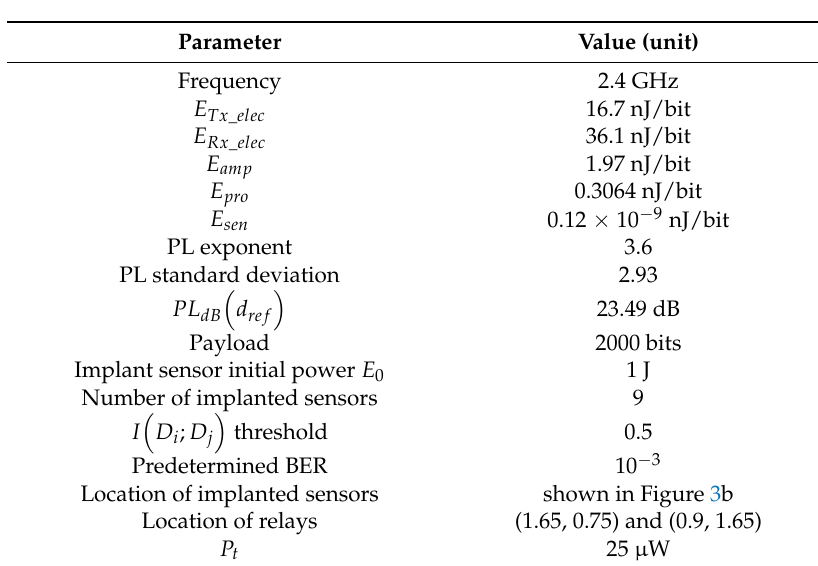
Figure 3. The topology of the proposed protocol. ( a ) Demonstration of the topology; ( b ) relay-based communication; ( c ) direct communication; ( d ) the coordination of implanted sensors. An initial energy value of 1 Joule (J) is offered equally to all implanted sensors. The number of Table 1. Simulation relay nodes is limited to two with coordinates (1.65, 0.75) and (0.9, 1.65) in accordance with [19]. The